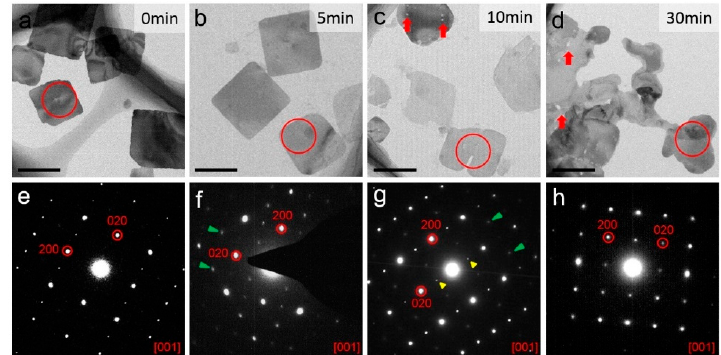
Figure 4. ( a – d ) TEM images of BA 2 PbBr 4 nanosheets after white light irradiation for 0, 5, 10, 30 min, respectively (bar = 1 μ m); ( e – h ) the corresponding SAED patterns of the nanosheets marked by red circles in ( a – d ), respectively. Green and yellow arrows indicate the presence of extra diffraction spots.